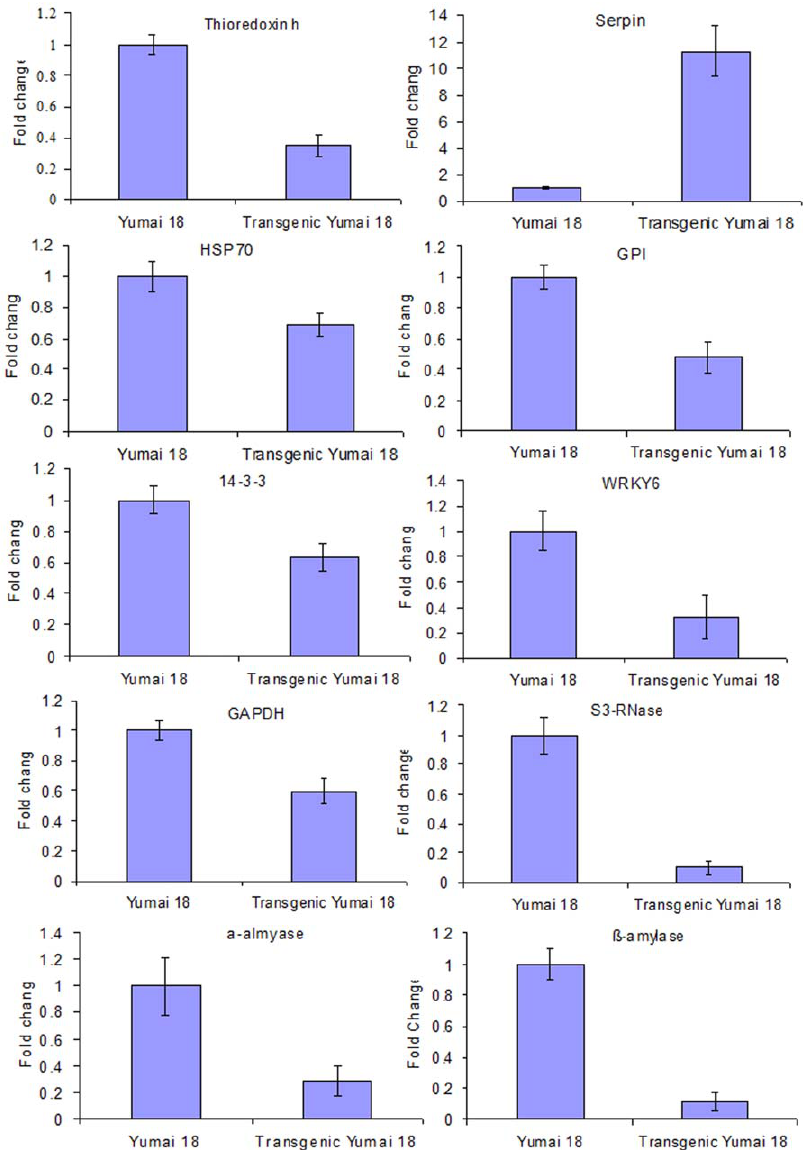
Figure 3. Changes in the relative abundance of selected transcripts in response to anti-trx s gene. Fold change was determined using the 2 2 DD Ct method and error bars represent the standard deviation of the mean